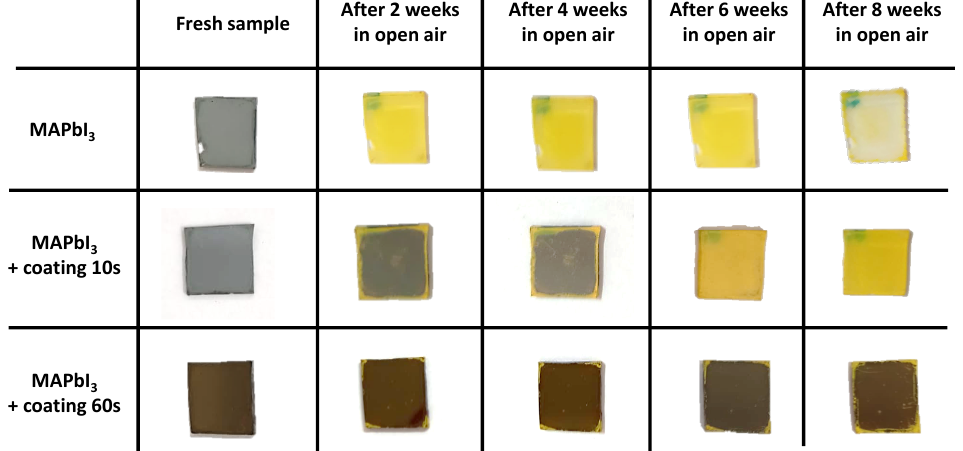
Figure 6. Photographs of pristine MAPbI 3 film and of samples obtained after the plasma deposition (10 and 60 s) of the fluorocarbon coating on the perovskite at different times of exposure to open air (0 – 8 weeks).